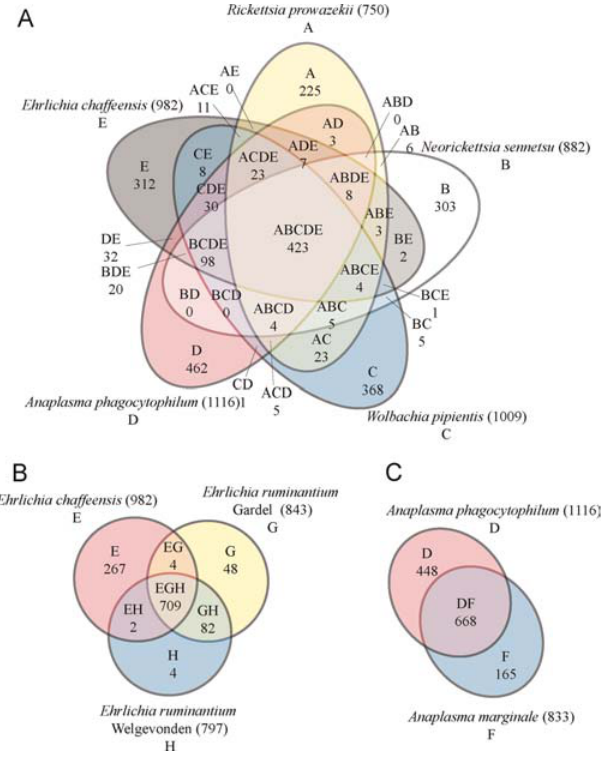
Figure 4. Comparison of the Rickettsiales Gene Sets The composition of ortholog clusters (see Materials and Methods) of representative Rickettsiales (A), Ehrlichia spp. (B), and Anaplasma spp. (C) were compared. Numbers within the intersections of different ovals indicate ortholog clusters shared by 2, 3, 4, or 5 organisms. Species compared are indicated in diagram intersections as follows. A, R. prowazekii; B, N. sennetsu; C, W. pipientis; D, A. phagocytophilum; E, E. chaffeensis; F, A. marginale; G, E. ruminantium Gardel; and H, E. ruminantium Welgevonden. DOI: 10.1371/journal.pgen.0020021.g004